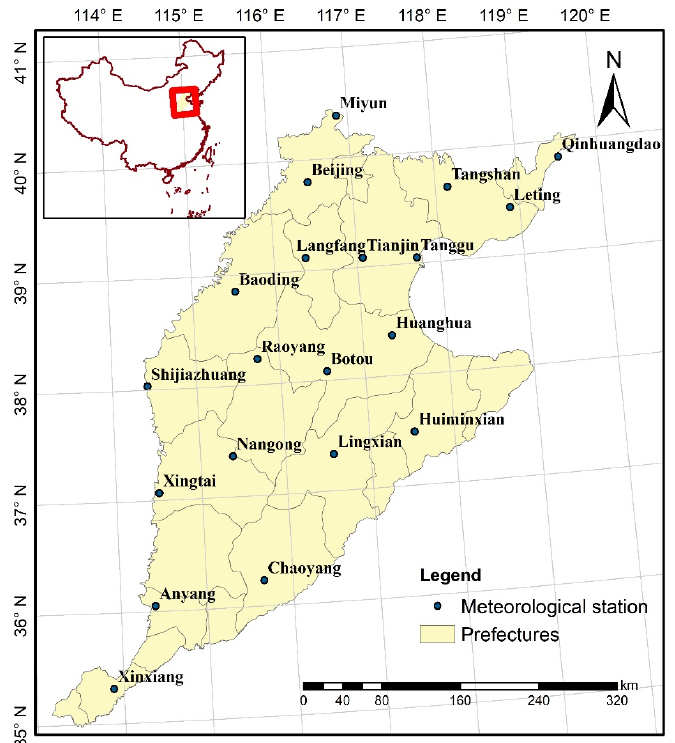
Figure 1. Location of the Haihe Plain within China and the distribution of weather stations.